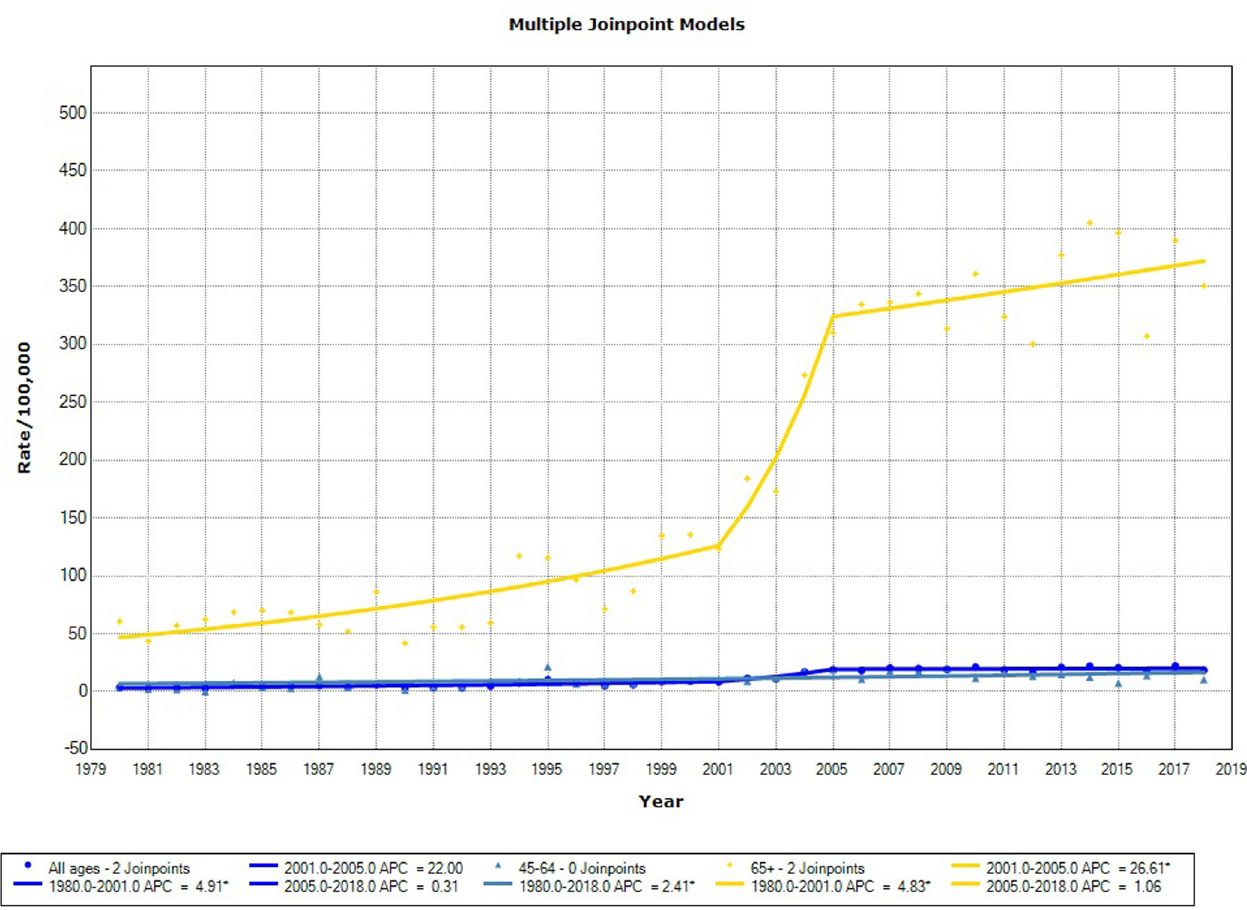
Fig 3. Mortality trends for prostate cancer in the state of Sergipe,